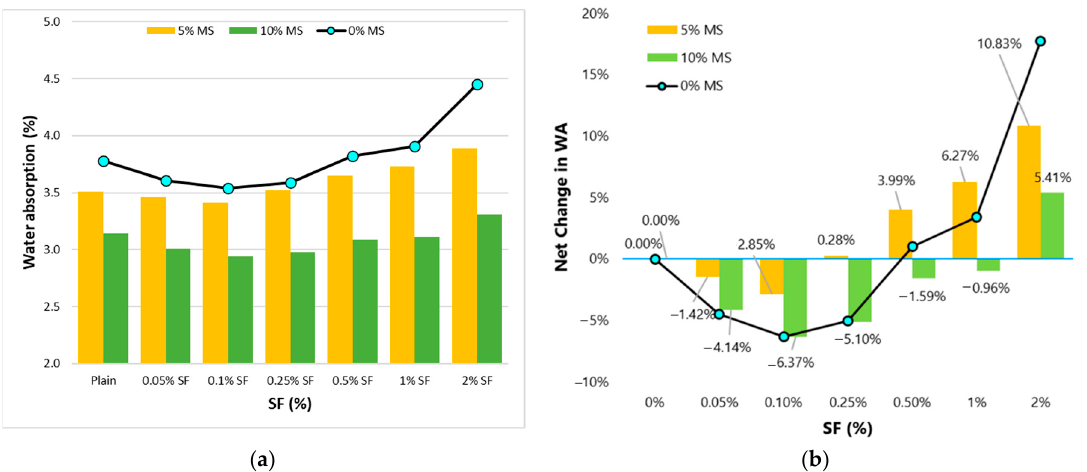
Figure 12. Water-absorption (WA) results ( a ) effect of MS on WA with varying SF dosage ( b ) effect of MS on the net change in WA with varying SF dosage.